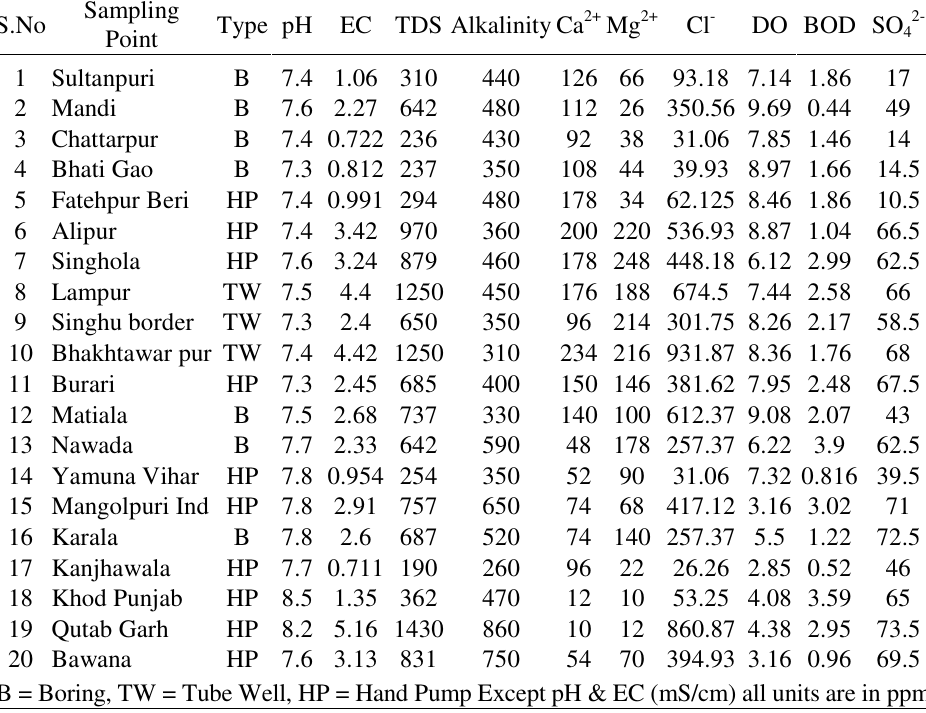
Table 1. The results of various physicochemical analyses of groundwater samples of